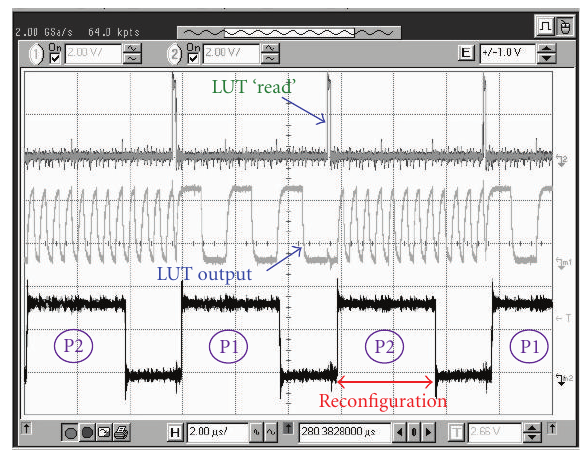
Figure 11: Experimental results illustrating the shadowed recon- figuration in our emulated MTJ RSRAM-based 4-inputs LUT. This RSRAM does not include any